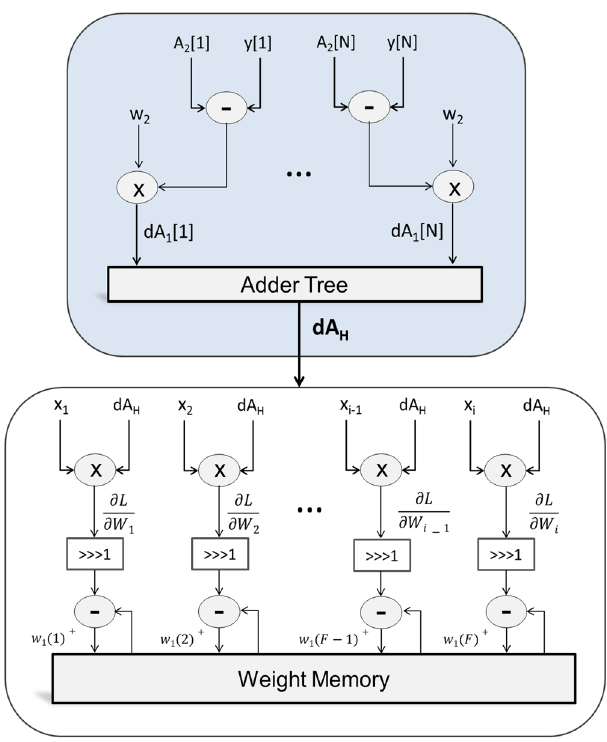
Figure 4. Internal Structure of the Layer 1 Learning Engine (Backward